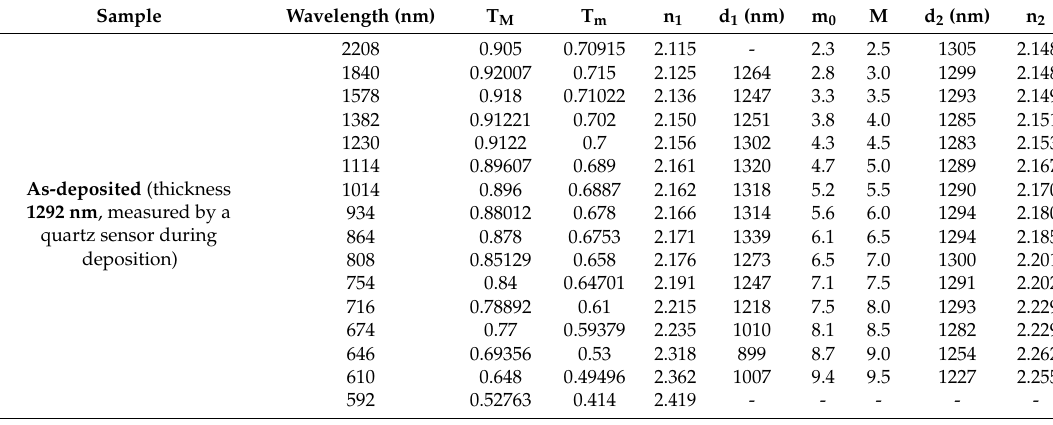
Table 2. Optical parameters obtained from the optical transmission measurements carried out using the second batch (as-deposited and annealed) of garnet